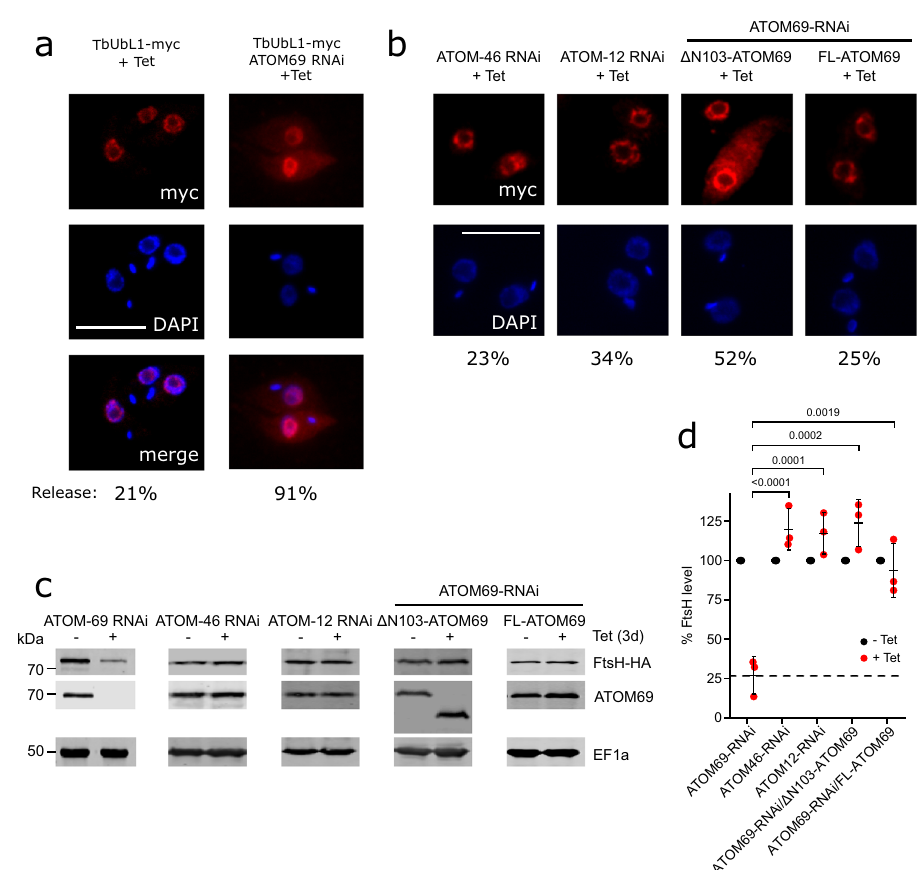
Fig. 4 Import defect induced by ATOM69 RNAi but not by other ATOM subunits causes a release of nuclear TbUbL1 to the cytosol. a Left, immuno fl uorescence (IF) analysis of a cell line allowing tetracycline-inducible expression of myc-tagged ubiquitin-like protein 1 (TbUbL1-myc + Tet). Right, IF analysis of a cell line allowing tetracycline-inducible expression of myc-tagged TbUbL1 together with simultaneous RNAi of the atypical translocase of the outer membrane 69 (ATOM69) (TbUbL1-myc/ATOM69-RNAi + Tet). Scale bar 10 μ m. Cells were induced for 3d. The % of the population displaying a TbUbL1-myc nuclear release phenotype is recorded below the images, 100 cells of each were analysed. This IF analysis was repeated independently at least three times with similar results. b IF analysis of cells expressing TbUbL1-myc with simultaneous RNAi of ATOM46, ATOM12 or ATOM69. Scale bar 10 μ m. Cells were induced for 2d (cell lines based on ATOM12 RNAi) or 3d (cell lines based on ATOM46 or ATOM69 RNAi). The ATOM69 RNAi cell lines were combined with tetracycline-inducible expression of either N-terminally truncated ( Δ N103-) or full length (FL-) ATOM69, respectively. This IF analysis was repeated independently at least two times with similar results. c Immunoblots depicting the change in abundance of the model substrate FtsH-HA in whole cells after tetracycline-inducible RNAi-mediated ablation of ATOM69, ATOM46 or ATOM12, or of ATOM69 in combination with tetracycline-inducible expression of either N-terminally truncated ( Δ N103-) or full length (FL-) ATOM69 as indicated. Note that for the ATOM69 RNAi cell line, the sections of blots used are already shown in Fig. 2a. 2 × 10 6 cells were loaded per lane. Elongation factor 1a (EF1a) is used as a loading control. d Quanti fi cation of triplicate immunoblots shown in c , with the FtsH-HA level of each uninduced cell line set to 100%. The level of FtsH-HA for each sample was normalised to its respective EF1a signal. Data are presented as mean values with error bars corresponding to the standard deviation of the mean of three independent biological replicates. Signi fi cance was calculated using a one way ANOVA followed by a Bonferroni posthoc test to allow for multiple comparisons, with the p values calculated indicated in the graph. Source data are provided as a Source Data fi